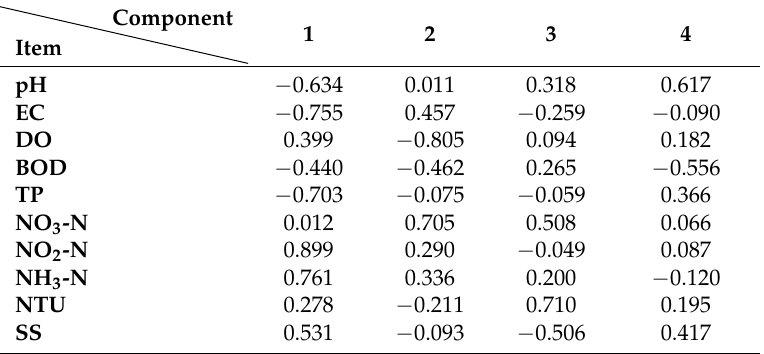
Table 7. Load matrix of the principal components of each water quality